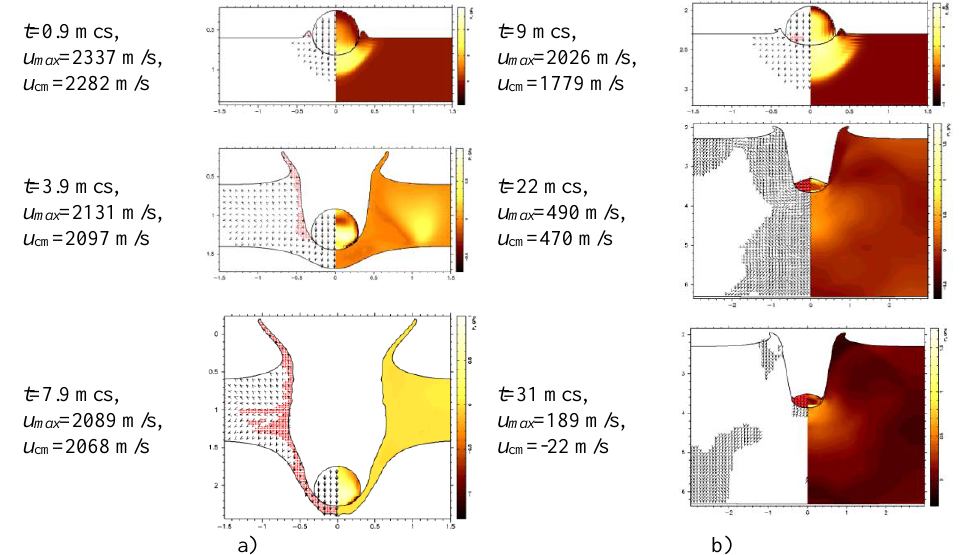
Fig 9. The chronogram of the interaction process between the drummer and the barrier made from PMMA ( a ), and with the barrier-“witness” ( b ) at V 0 = 2441